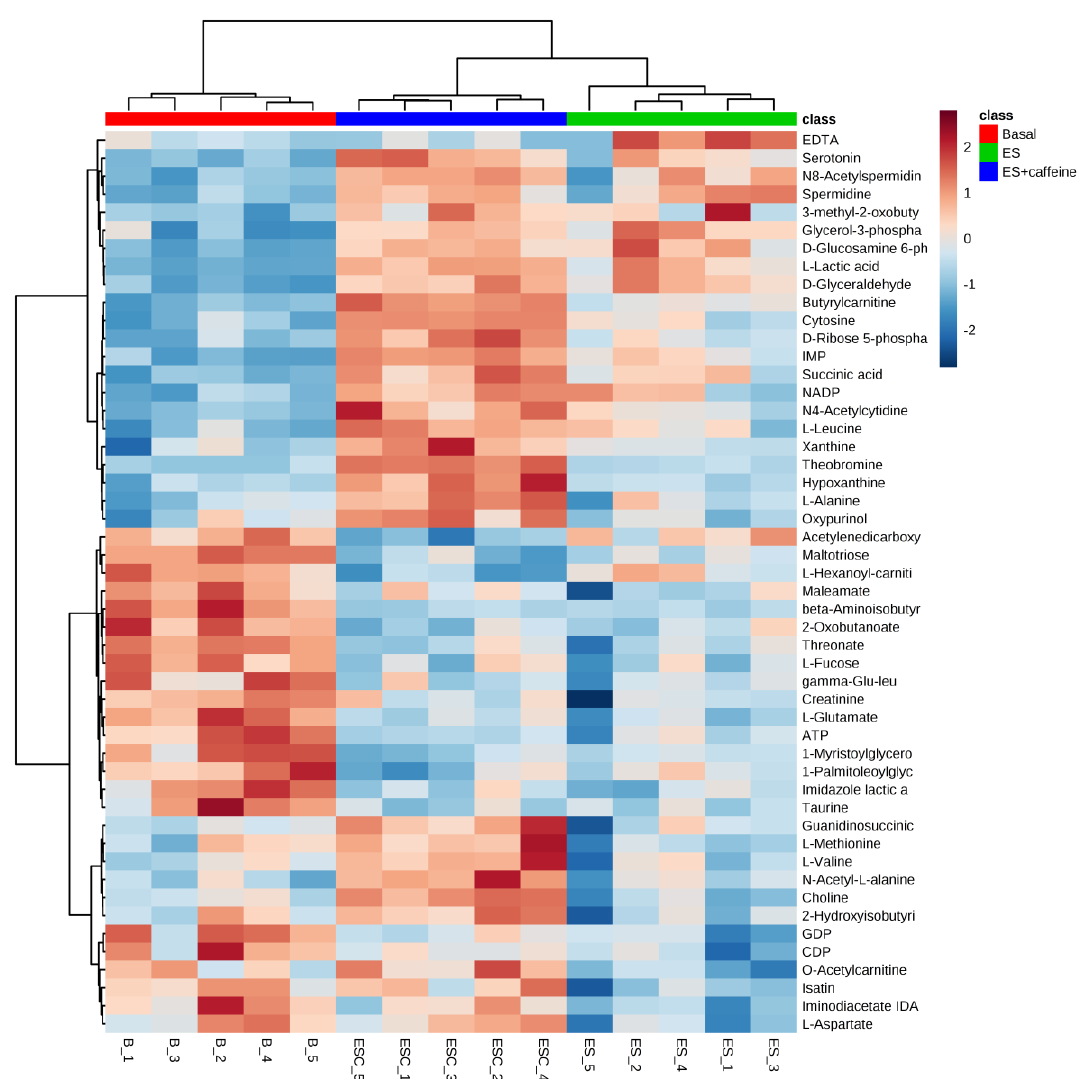
Figure 3. A heat map of hierarchical clustering analysis comparing the 50 different metabolites among groups. The heat map patterns among groups were distinguishable. The color red demonstrates that the relative content of metabolites is high and blue demonstrates that they are low.